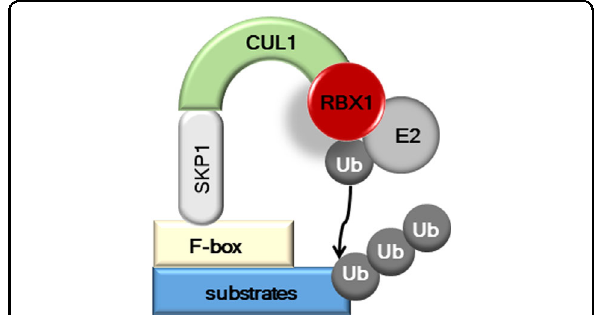
Fig. 1 Basic molecular structure of the SCF complex. The SCF (SKP1-CUL1-F-box protein) ubiquitin ligase complex is the most well- characterized cullin RING ubiquitin ligase (CRL). Since the F-box proteins contain approximately 69 different components that bind to SKP1, many different combination of speci fi c SCF complex formation are possible with a selective substrate and depending on the cellular context. Moreover, eight cullin proteins add a more complicated combinational probability for tissue, developmental, and stimuli speci fi cities. Finally, the ubiquitination in mono-, multi-, single-chain, poly-chain, and branched-chain patterns might indicate precise regulation of the cellular functions of proteins by re fl ecting diverse cell